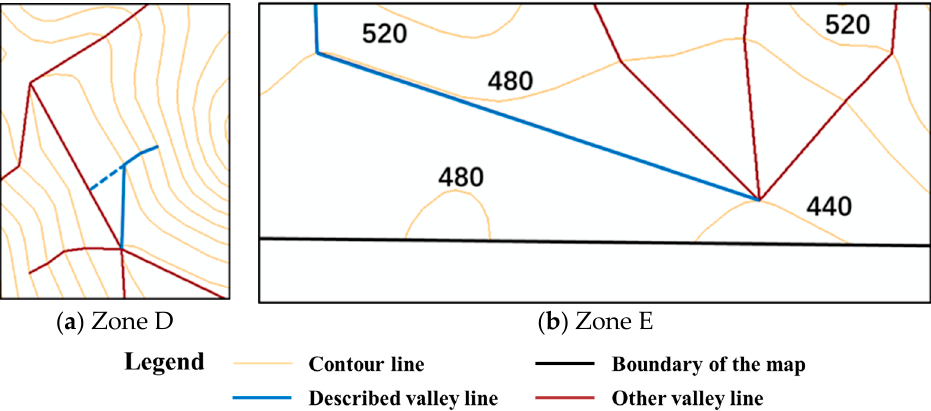
Figure 13. Enlarged view of Zones D and E from Figure 11. The numbers in ( b ) indicate the elevation of the contour line.